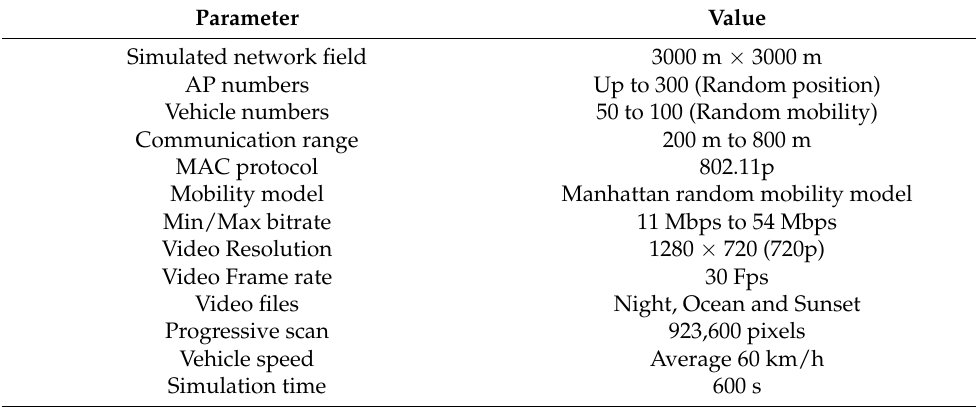
Table 2. Simulation